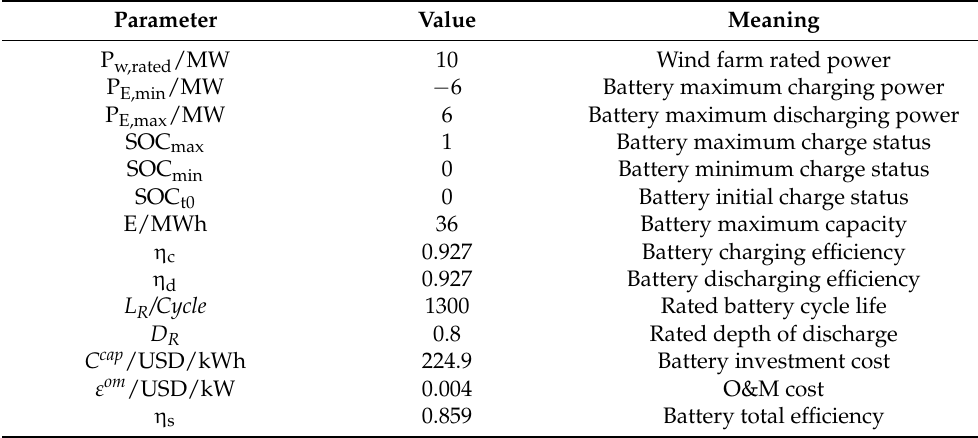
Table 2. System parameters of wind-storage.